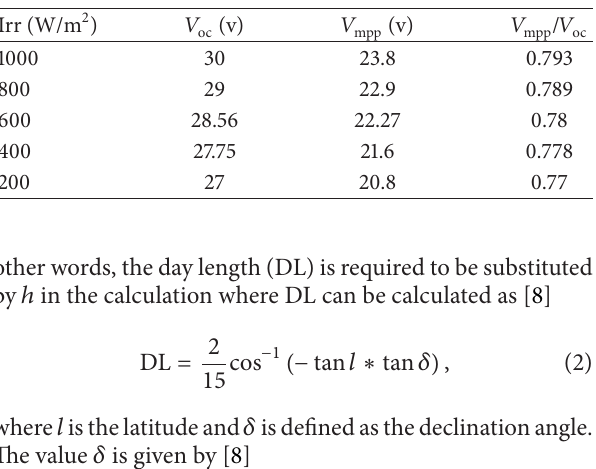
Table1:Cellopencircuitvoltageandmaximumpowerpointvoltage at different